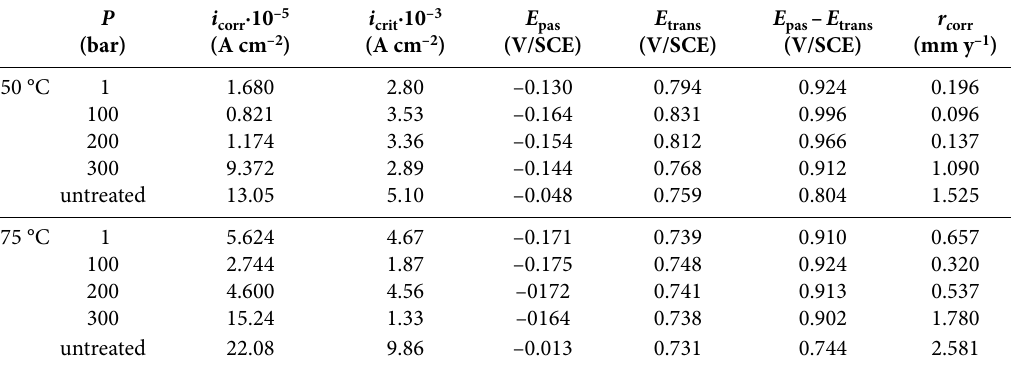
Table 2. Parameter values from potentiodynamic curves for AISI 347.